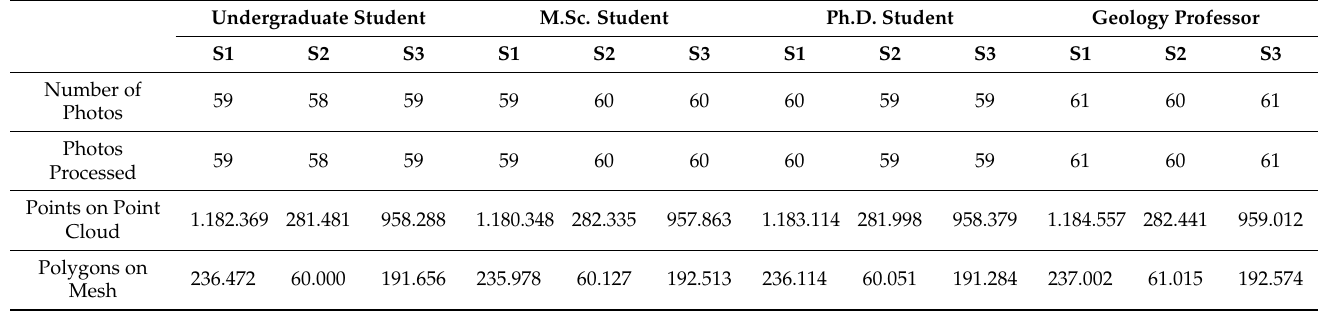
Table 7. Results of the second reconstruction after the methodological procedures.